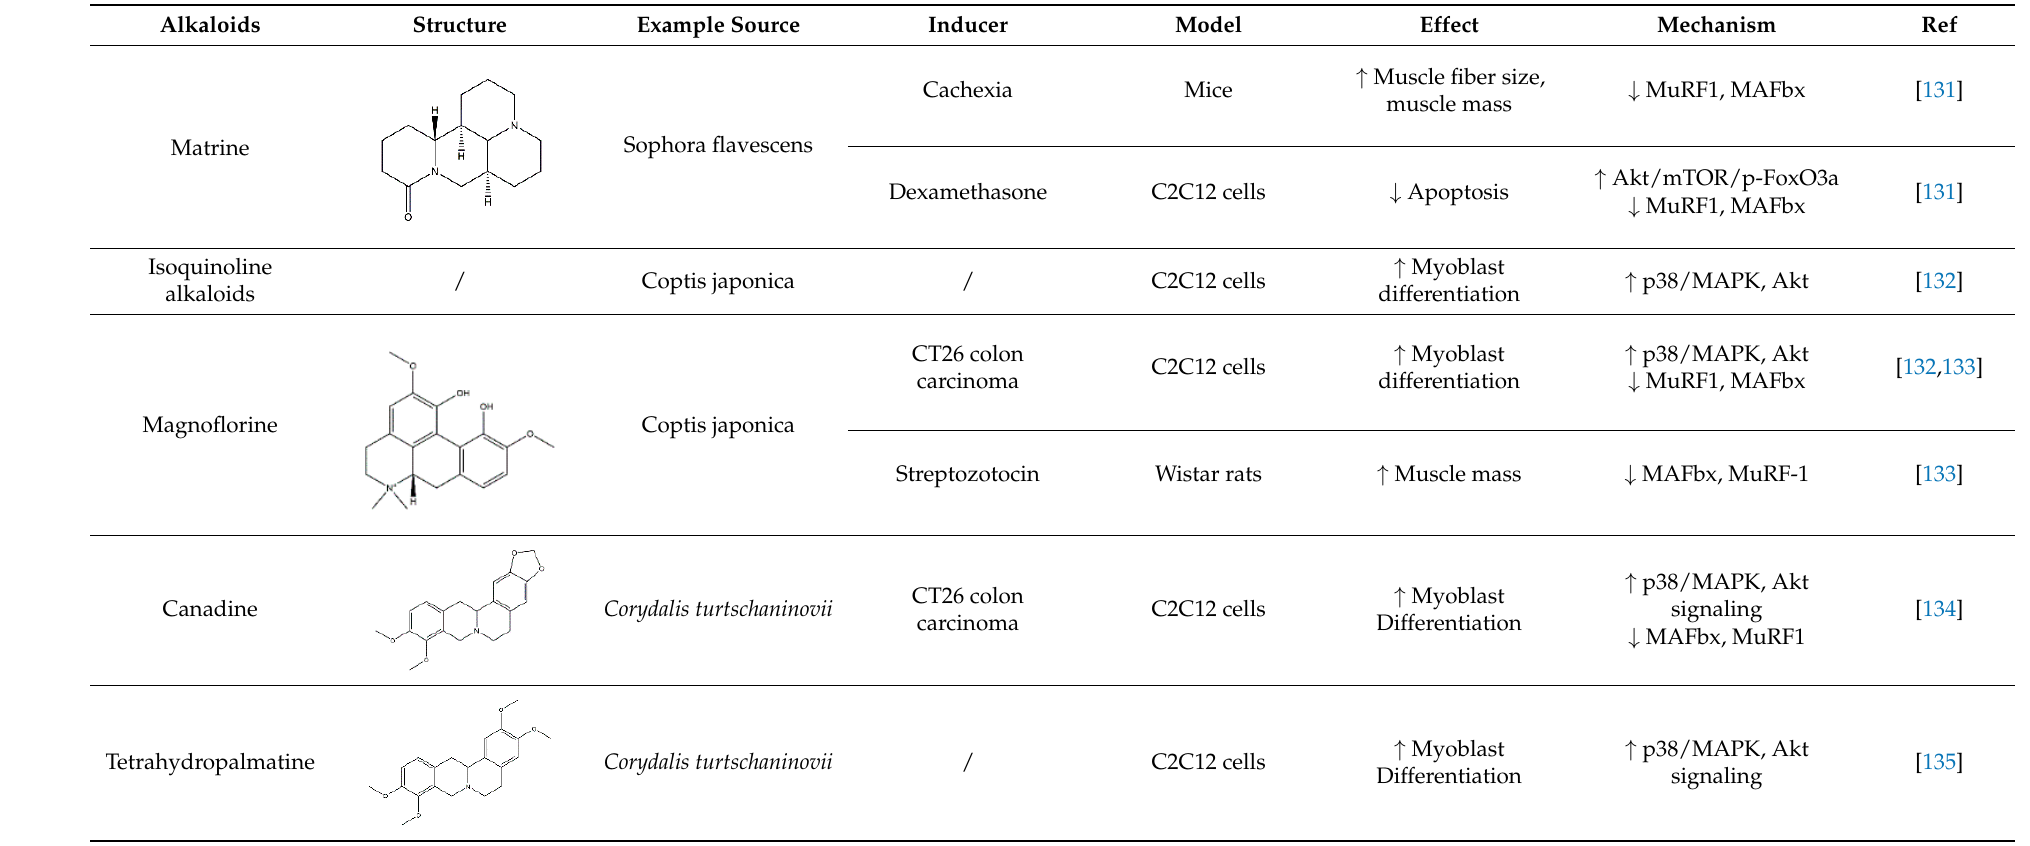
Table 8. Alkaloids in the prevention of the muscle atrophy in vitro/vivo.